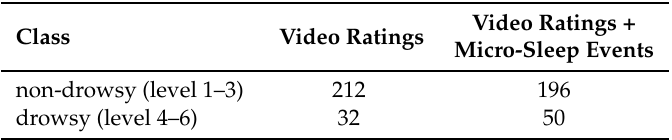
Table 4. Distribution of number of video ratings in absolute numbers across grouped drowsiness levels before and after integration of micro-sleep